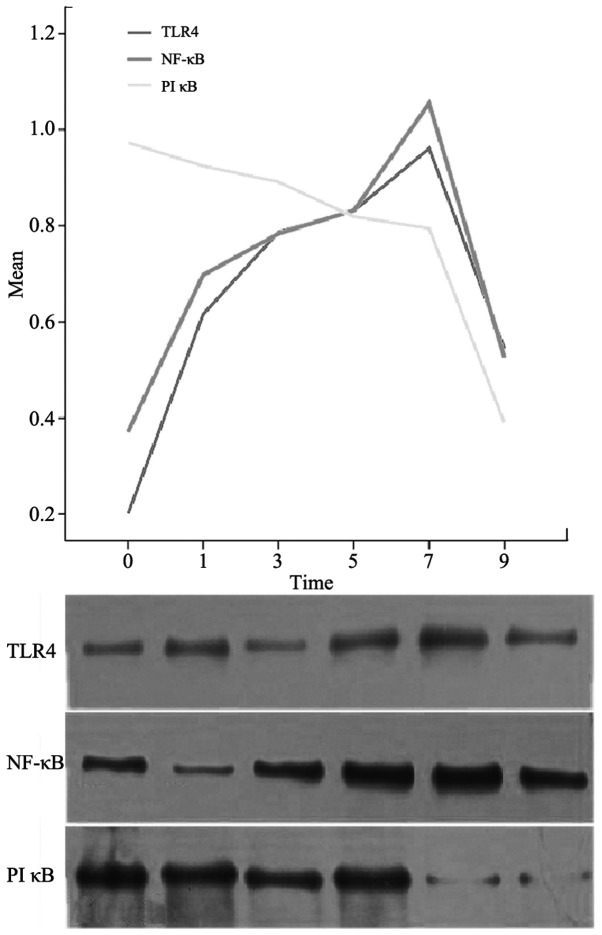
Protein expression of Toll-like receptor (TLR4), NF-κB and PIκB. From day 0 to 1 of high-fat diet stimulation, the expression of TLR4 and NF-κB proteins significantly increased. The protein expression level of TLR4 maintained an increasing trend from day 1 to 7 and the daily rate of increase was less than that on day 1. The protein expression of NF-κB maintained an increasing trend from day 1 to 7 and the rate of increase on days 5–7 was similar to that on day 1. The protein expression levels of TLR4 and NF-κB peaked on day 7 (P<0.05), then demonstrated a decreasing trend. The expression of the PIκB protein demonstrated a decreasing trend from day 0 to 9. The rate of decrease on days 7–9 was significantly different from that on days 0–7, and was the lowest on day 9 (P<0.05). The changing trends of TLR4, NF-κB and PIκB were consistent from day 7 to 9, with no statistically significant difference in rate (P>0.05).